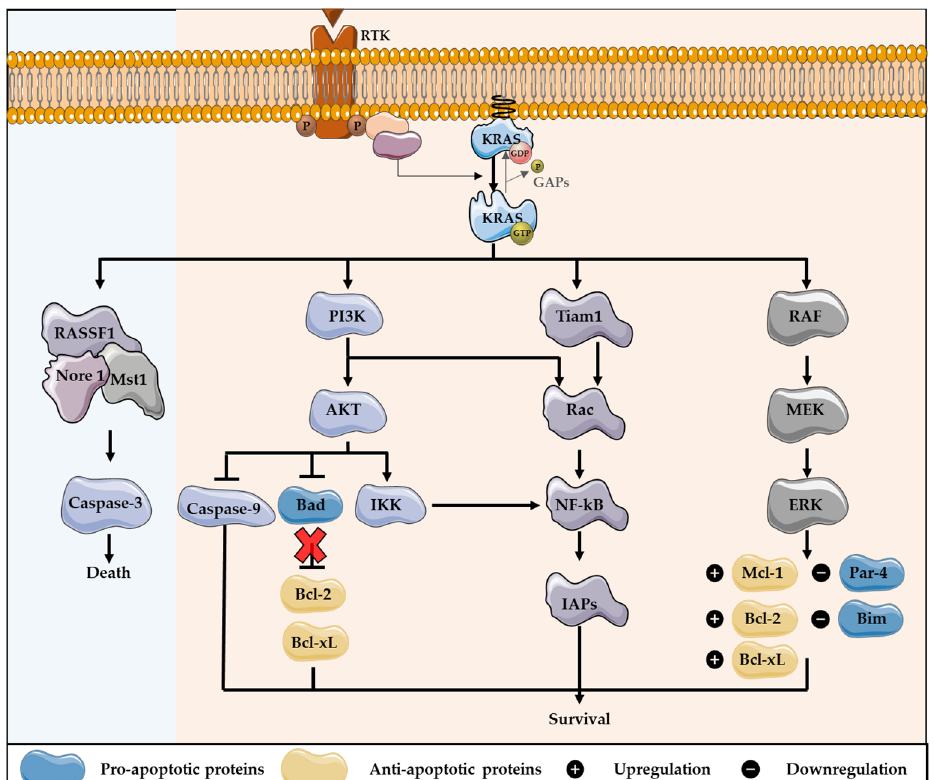
Figure 2. KRAS downstream signaling activation cross-talk with apoptosis pathways regulation. KRAS can modulate apoptosis, through the regulation of the downstream effector pathways, which mainly results in cell survival, especially through the activation of PI3K pathway. After, KRAS activates PI3K and AKT: the last protein leads to the inhibition of Bad, a pro-apoptotic protein of the Bcl-2 family, preventing the inhibition of the anti-apoptotic proteins Bcl-2 and Bcl-xL. Furthermore, PI3K can activate Rac, which consequently activates the transcription factor NF-kB, involved in the production of survival signals, as NF-kB promotes the transcription of several anti-apoptotic genes, including inhibitors of apoptotic proteins (IAPs). In addition, Rac can lead to the activation of NF-kB through Tiam 1, as also AKT can phosphorylate and activate IKK, thus stimulating NF-kB. Additionally, the induction of MAPK pathway contributes to the control of apoptosis, through MEK activity. Thus, KRAS leads to the downregulation of Par-4, a pro-apoptotic protein, and the expression level of several proteins that belong to Bcl-2 family is regulated. This includes the downregulation of Bim, a pro-apoptotic member, and the upregulation of the anti-apoptotic proteins Bcl-2, Bcl-xL and Mcl-1. In contrast, KRAS can engage pro-apoptotic signaling pathways, through the activation of RASSF1/Nore 1/Mst1 complex, stimulating caspase-3